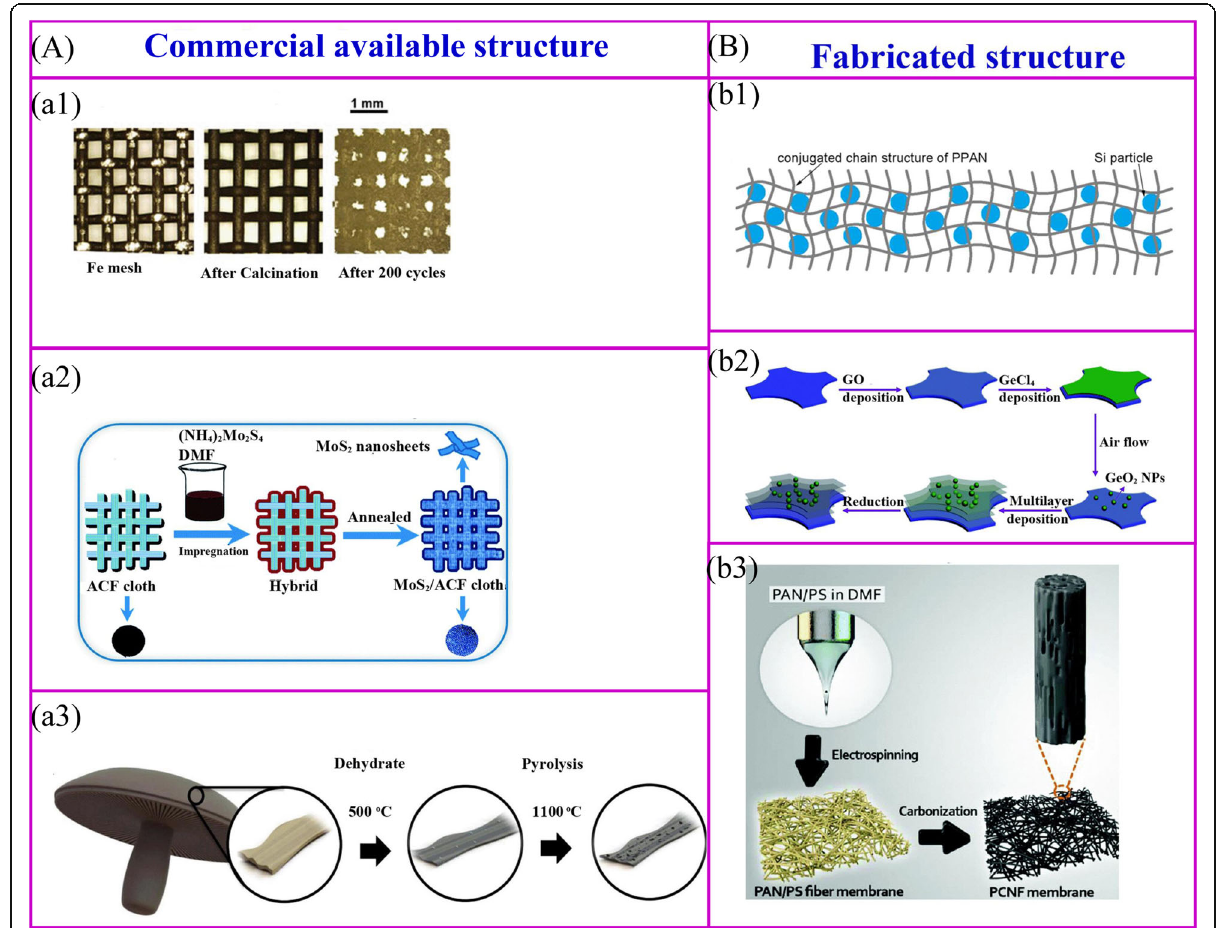
surface of conductive structure by thermal treatment [35]. a3 Biomass can be carbonized to achieve the carbon architecture [32]. b1 The mixture of polymer and active materials can be carbonized to achieve the binder-free electrode [36]. b2 Hierarchical structure can be obtained by multiple processes [37]. b3 Binder-free electrode can be obtained by thermal treatment the electrospinning membrane